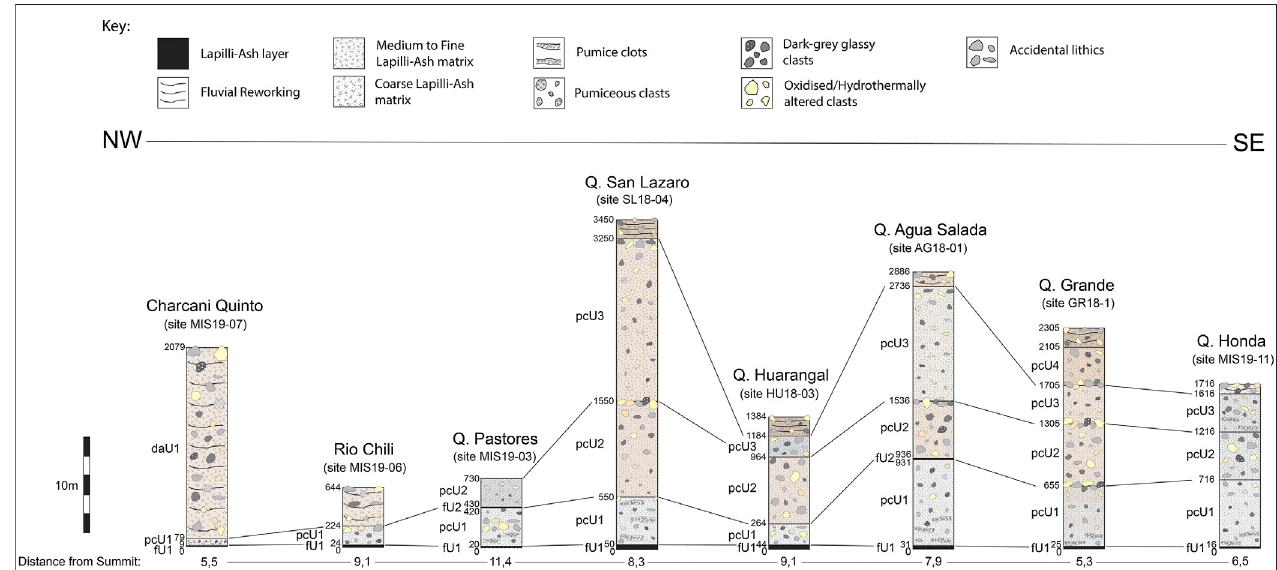
FIGURE 5 | Selected correlated stratigraphic sections with deposit facies characteristics (grain size, componentry) from the seven drainages affected by the 2070 cal yr BP pyroclastic currents. See Figure 4 for the locations of the different sections and sampling sites.